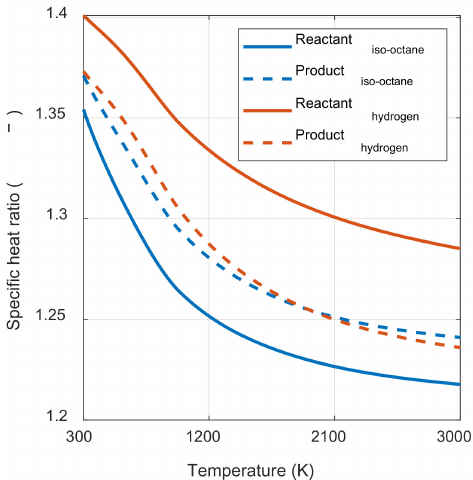
Figure 5. Specific heat ratio of iso-octane / air mixture and hydrogen / air